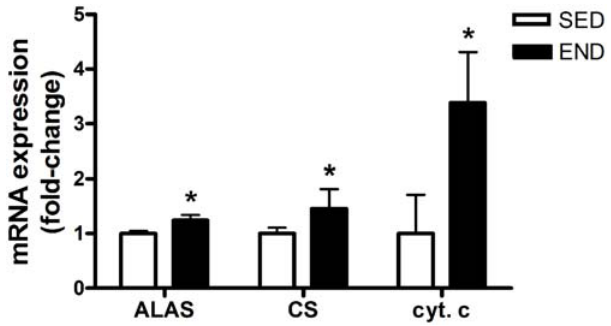
Figure 2. Transcription of PGC-1 a target genes following exercise. Activation of ALAS, CS and cyt. c mRNA expression (fold- change) in the quadriceps of C57Bl/6J mice (N=7/group) 3-hour following an acute bout of END exercise vs. SED group. ALAS, CS and cyt. c mRNA expression are normalized to b -2 microglobulin. Asterisks denote significant changes (P # 0.05).